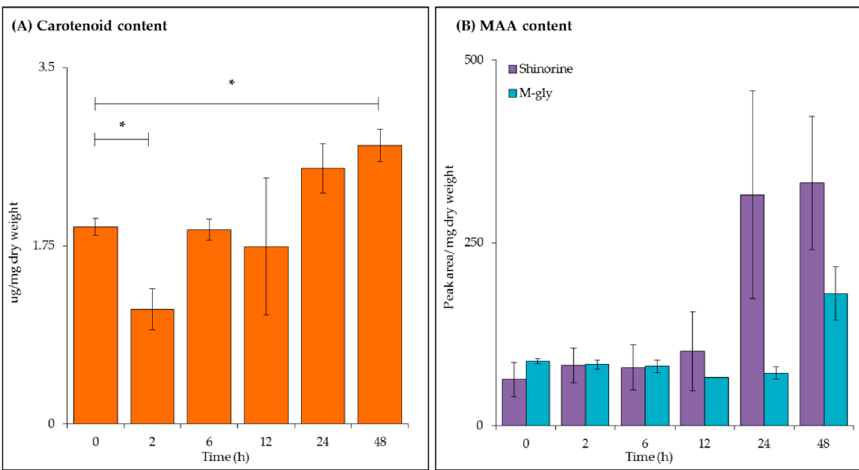
Figure 3. Carotenoid and mycosporine-like amino acid (MAA) analysis of C. fritschii extracts during UV-B exposure. (A) Total carotenoid concentration as measured by UV-visible spectroscopy and (B) shinorine and mycosporine-glycine (m-gly) content measured by high-performance liquid chromatography (HPLC) analysis. All values are the mean of three biological replicates (normalised to dry weight) ± standard error. Statistical significance was measured using a two-sample T-test with equal variance; * = 0.05 ≥ p ≥ 0.01, ** = 0.01 ≥ p ≥ 0.001 and *** = p ≤ 0.001.